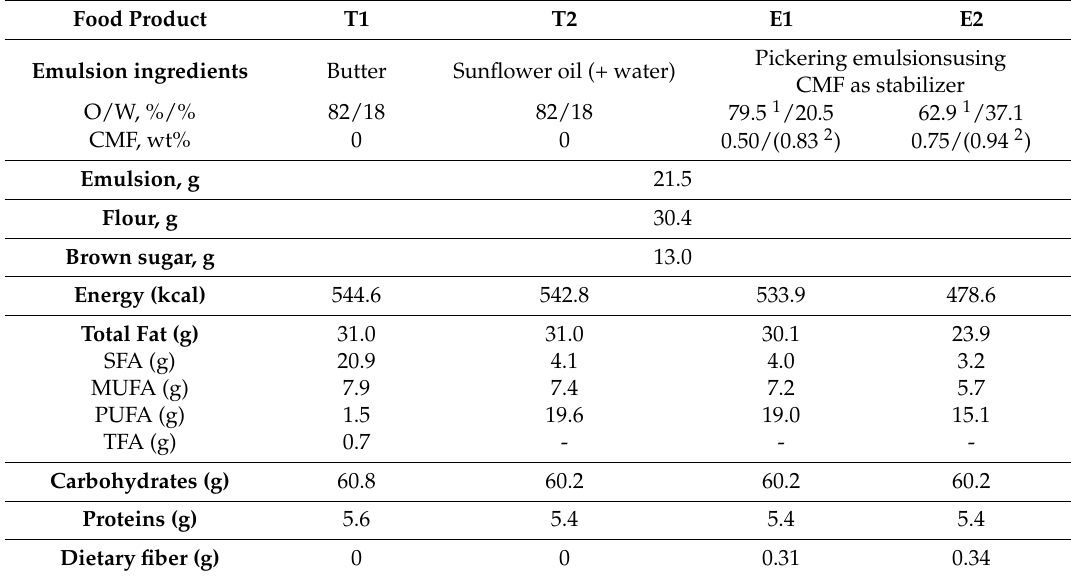
Table 3. Nutrition facts (per 100 g